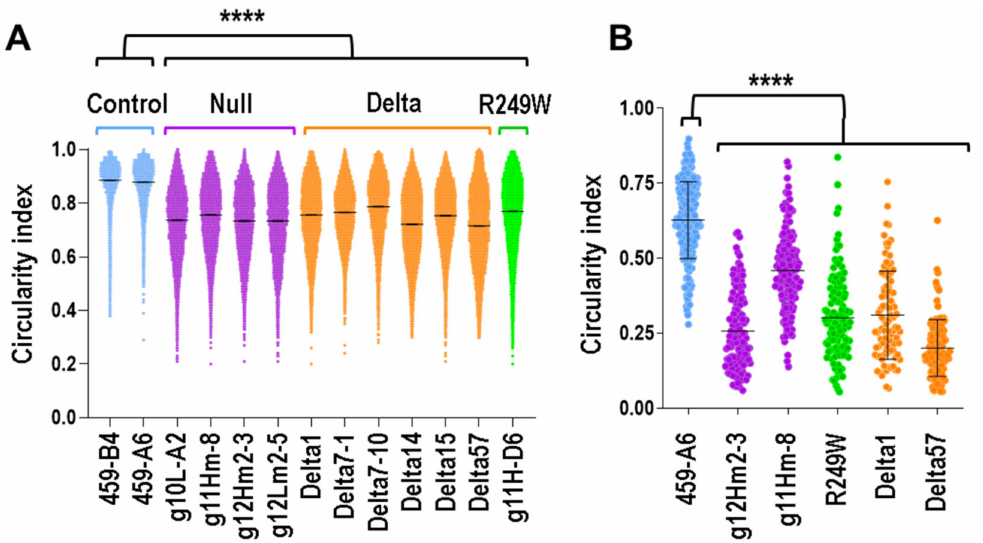
Figure 3. Nuclear morphology was altered in mouse myoblasts carrying Lmna exon 4 mutations. ( A ) Circularity index was calculated in nuclei from clones asynchronously growing in 2D cultures (**** p < 0.0001; n > 5000 nuclei per clone). ( B ) Plot shows the circularity index from clones encapsulated in a 3D pattern. Data were compared using an unpaired Mann–Whitney U test (**** p < 0.0001). Blue, purple, green, and orange colors indicate control, null, R249W, and delta clones,